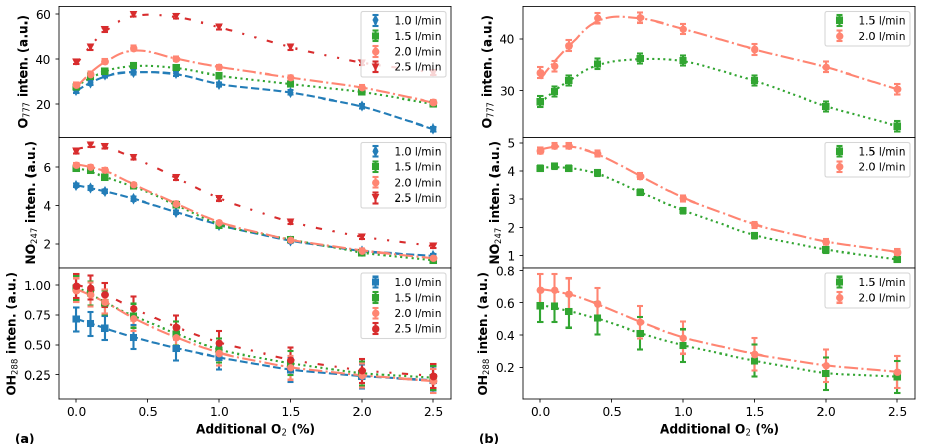
Figure 5. Intensities of selected lines/bands from O, NO, and OH radicals as a function of the additional O 2 percentage for different He flow rates (indicated in the curve legends). The data were acquired for distances d = 3 mm in ( a ) and d = 5 mm in ( b ). Symbols represent experimental data and lines are trend